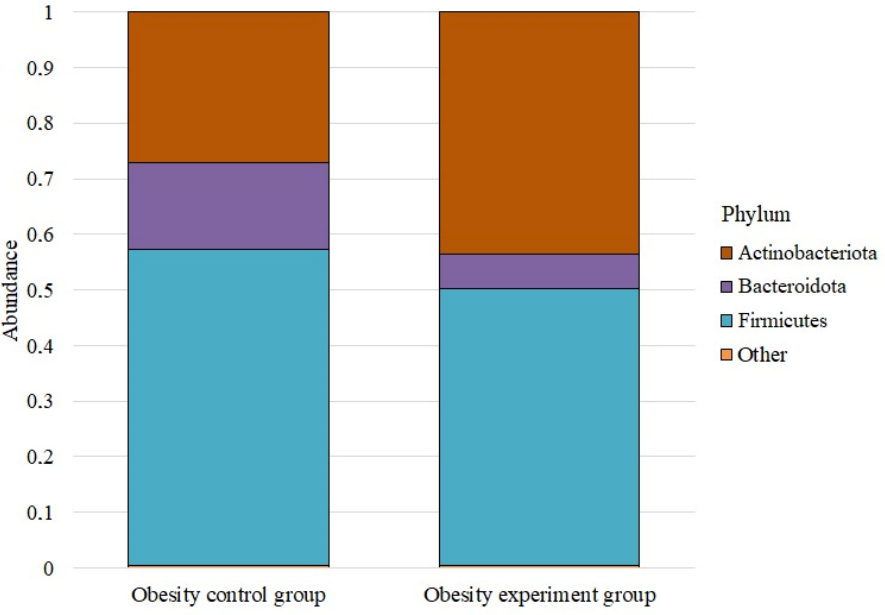
Figure 1. The average abundance of phyla in the studied groups. The phylum Firmicutes dominated in both cases. Before taking lactic acid bacteria, its abundance was 0.569 ± 0.072; after taking it, it decreased to 0.498 ± 0.048. The phylum Actinobacteriota was the next most numerous both before and after taking the lactic acid bacteria supplement. In the control group, its abundance was 0.272 ± 0.025, while in the experimental group, it was 0.436 ± 0.036. The abundance of the phylum Bacteroidota before taking the supplement was 0.155 ± 0.078; after, it was—0.061 ± 0.020. Proteobacteria were next, with an abundance of 0.003 ± 0.001 and 0.005 ± 0.001, respectively. The